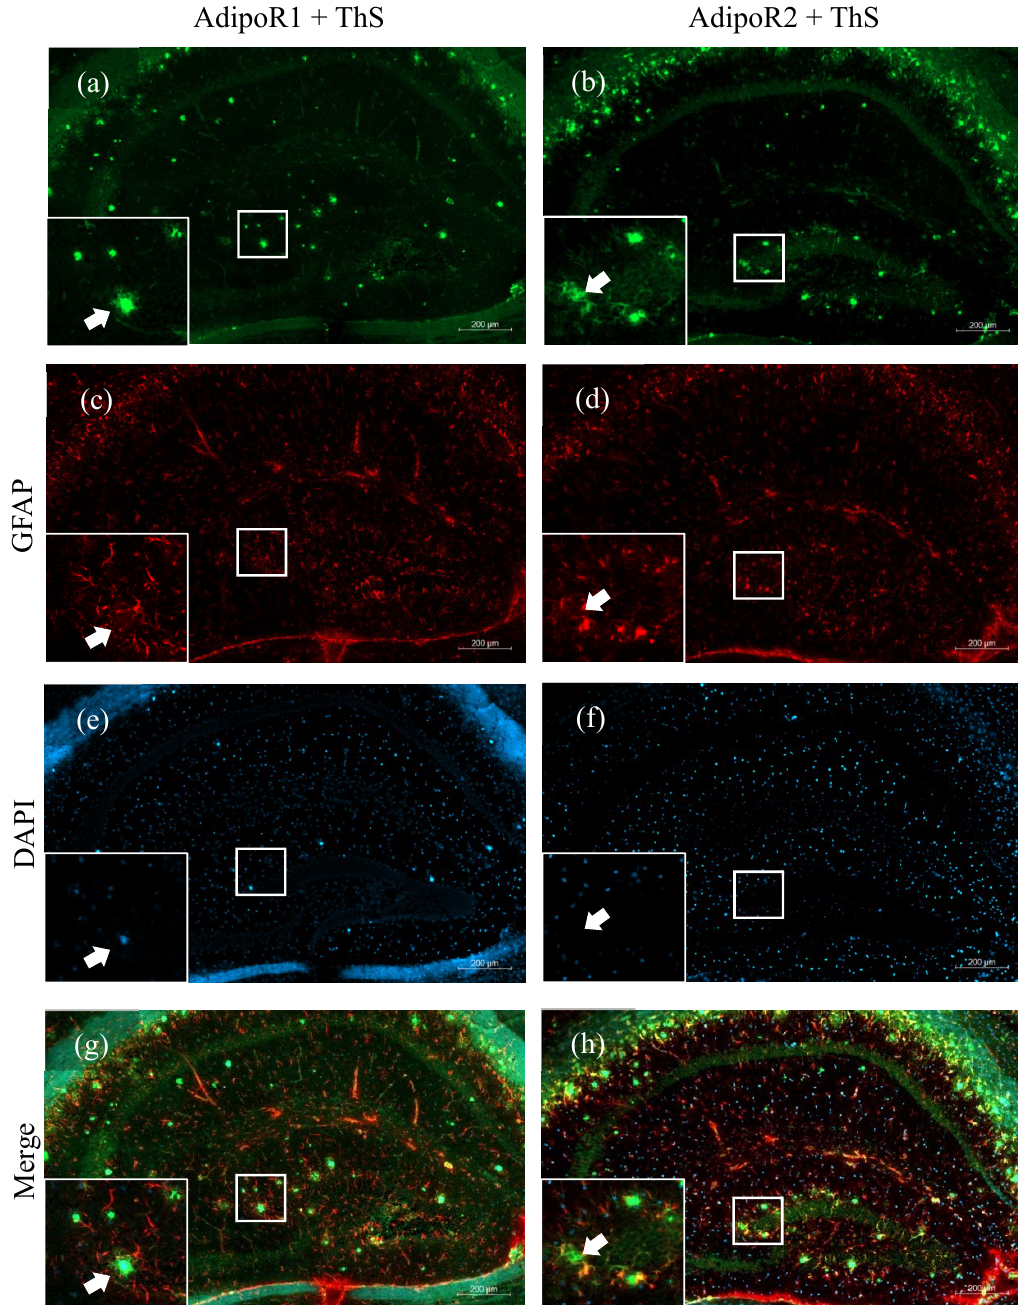
Figure 4. Amyloid plaque staining and adiponectin receptor expression in the hippocampi of 48–52-week-old 5XFAD mice. AdipoR1 ( a ) double-labelled with GFAP ( c ) and counterstained with 4′,6-diamidino-2-phenylindole (DAPI) ( e ) displayed no AdipoR1-expressing astrocytes surrounding Thioflavin-S-stained amyloid plaques (arrows) in the hippocampus ( g ). Astrocytes expressing AdipoR2 ( b ) double-labelled with GFAP ( d ) and counterstained with DAPI ( f ) can be seen surrounding amyloid plaques (arrows) ( h ). Images were acquired at 20 × magnification. Scale bars for ( a – h ) are 200 µ m. Scale bars for zoomed-in figures are 20 μ m.